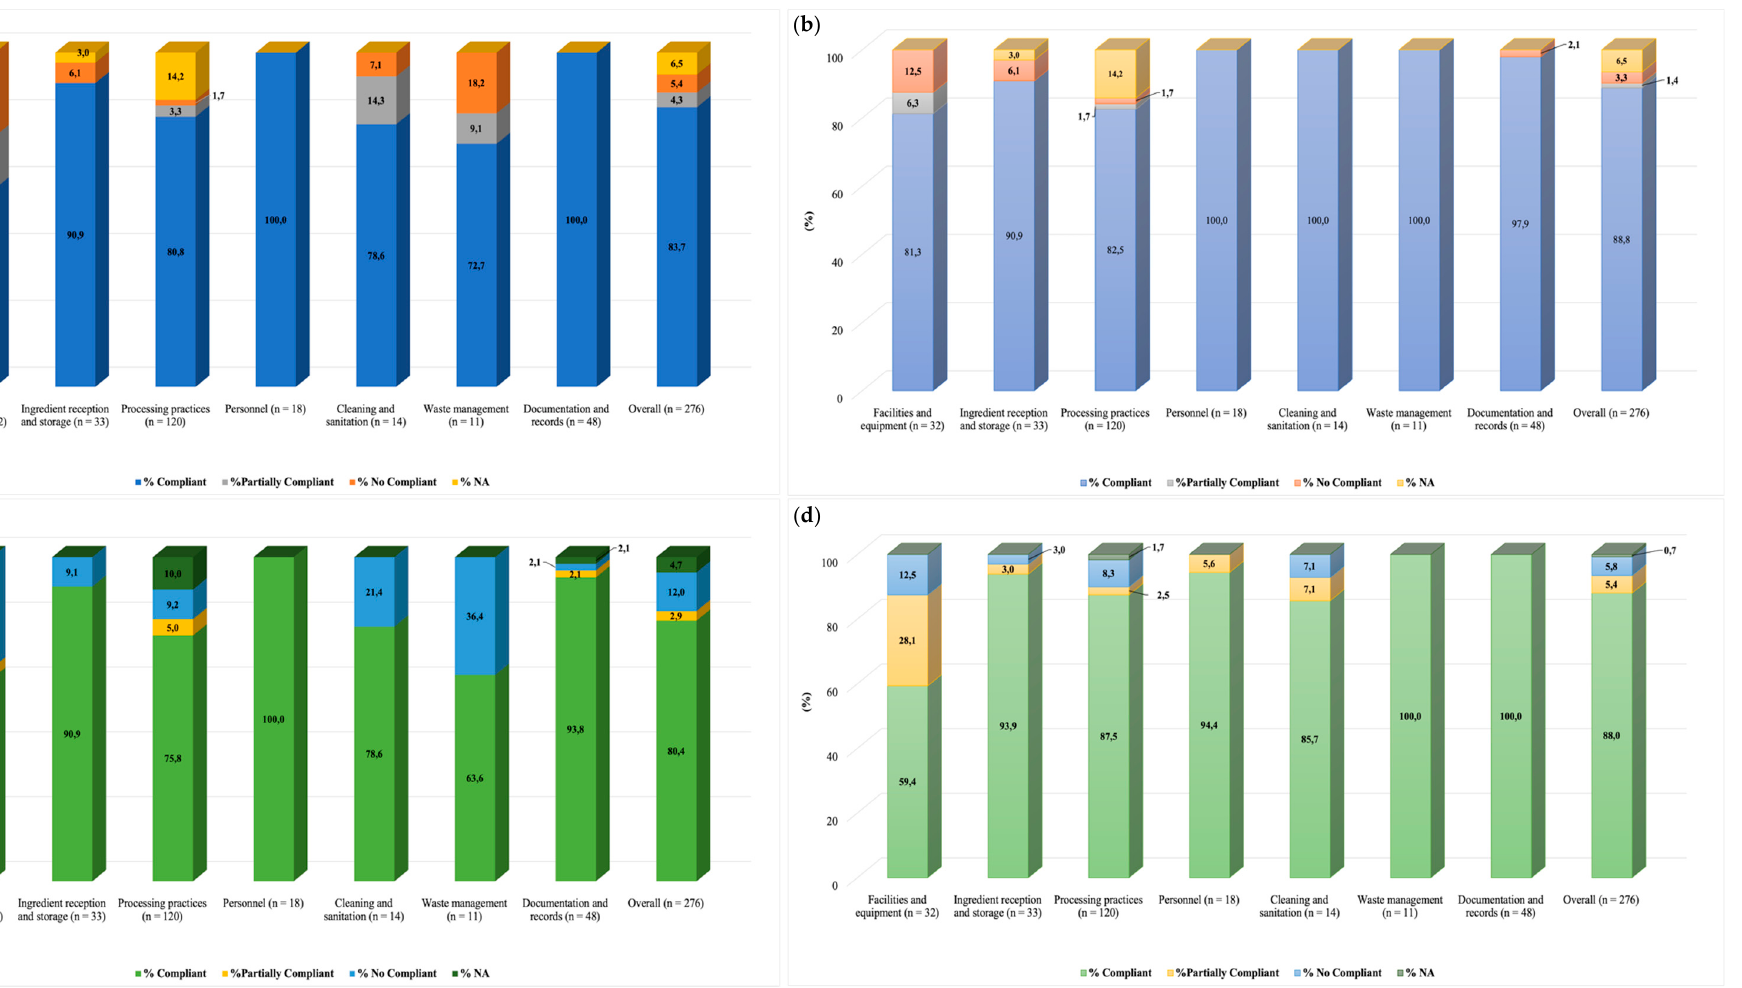
Figure 4. Audit results. Percent of compliant for each section analyzed. FSOp-A: ( a ) first audit (visit 1) and ( b ) second audit (visit 3). FSOp-B: ( c ) first audit (visit 1) and ( d ) second audit (visit 3).